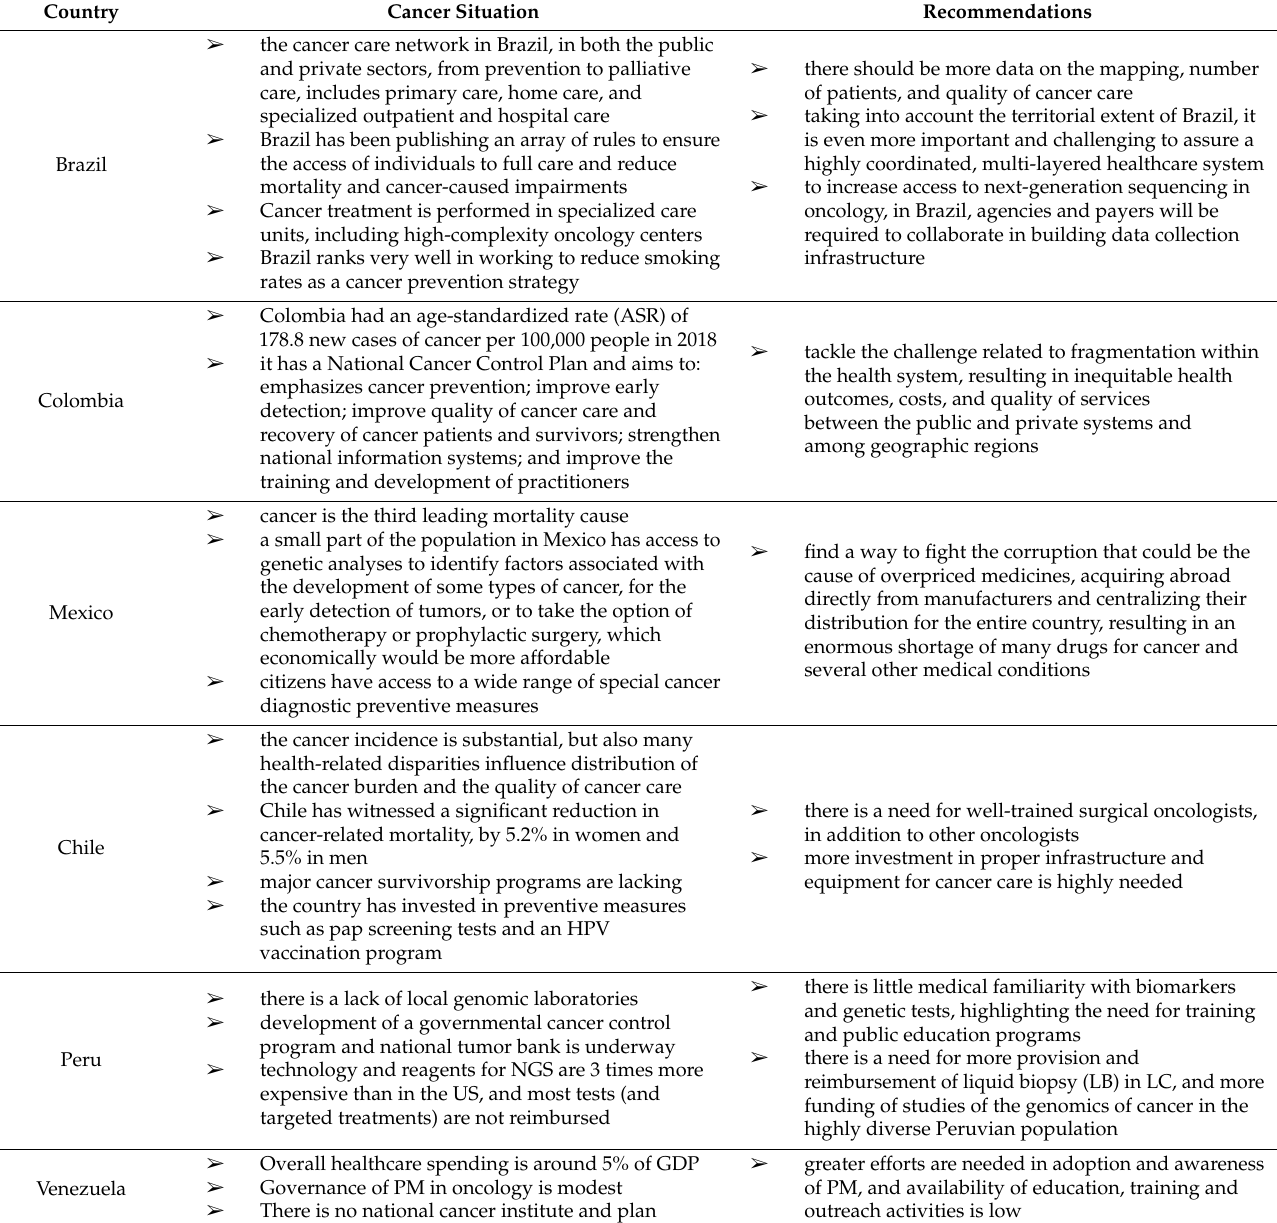
Table 4. Cancer situation and related recommendations in different LATAM